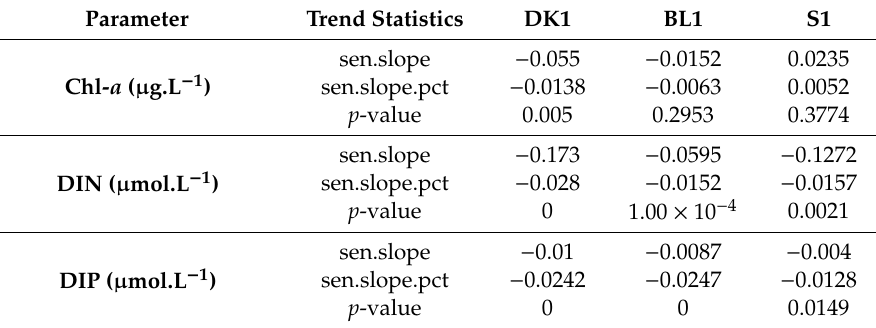
Table 2. Statistics of global trend analysis for the coastal stations D1, B1 and S1 for the period 1998–2018. Sen.slope: trend in original units per year; Sen.slope.pct: trend in percent of mean quantity per year, p -value: in bold when significant ( α = 0.05 or